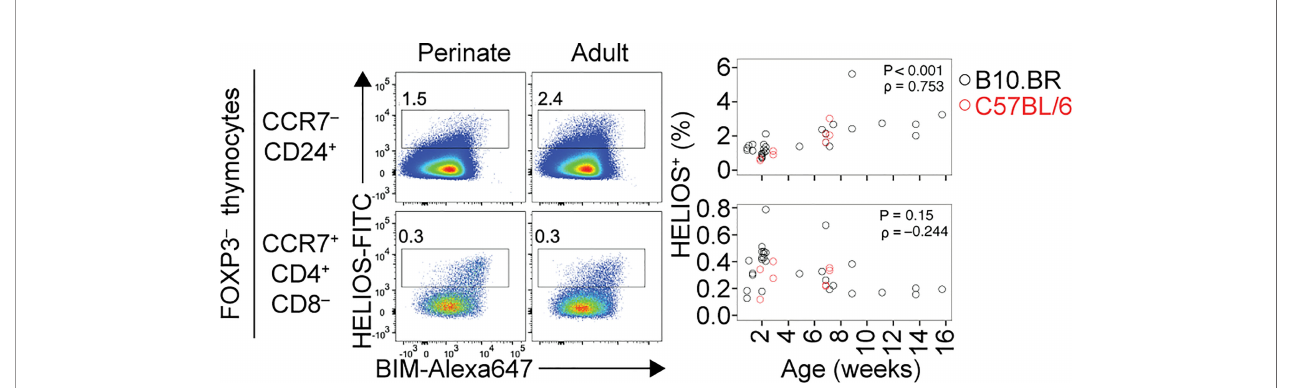
FIGURE 1 | Age-dependent shift in cortical and medullary tolerance induction in the thymus. Flow cytometry plots (left) show HELIOS/BIM phenotypes of Foxp3 –